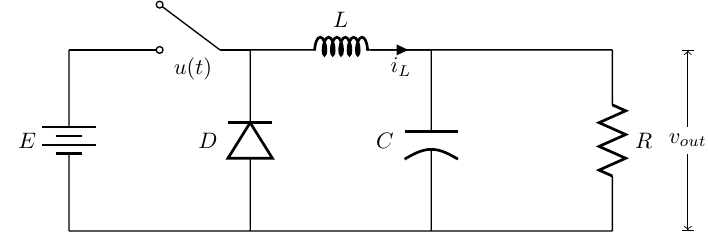
Figure 1. Generic DC–DC buck converter